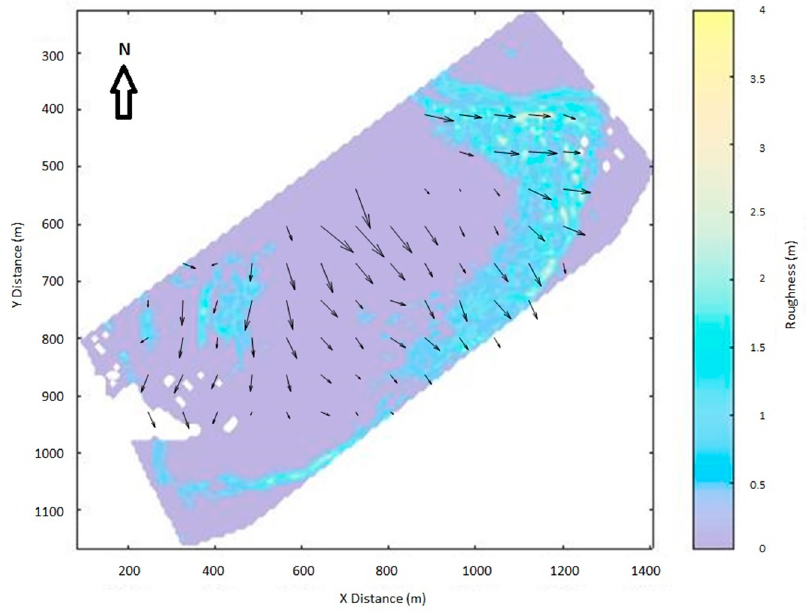
Figure 9. Suess Glacier PIV results for 100 m × 100 m gridded data. The color scale shows the glacier surface roughness (average 0.4 m). Glacier surface velocities are higher in the center of the glacier and decrease towards the edges.